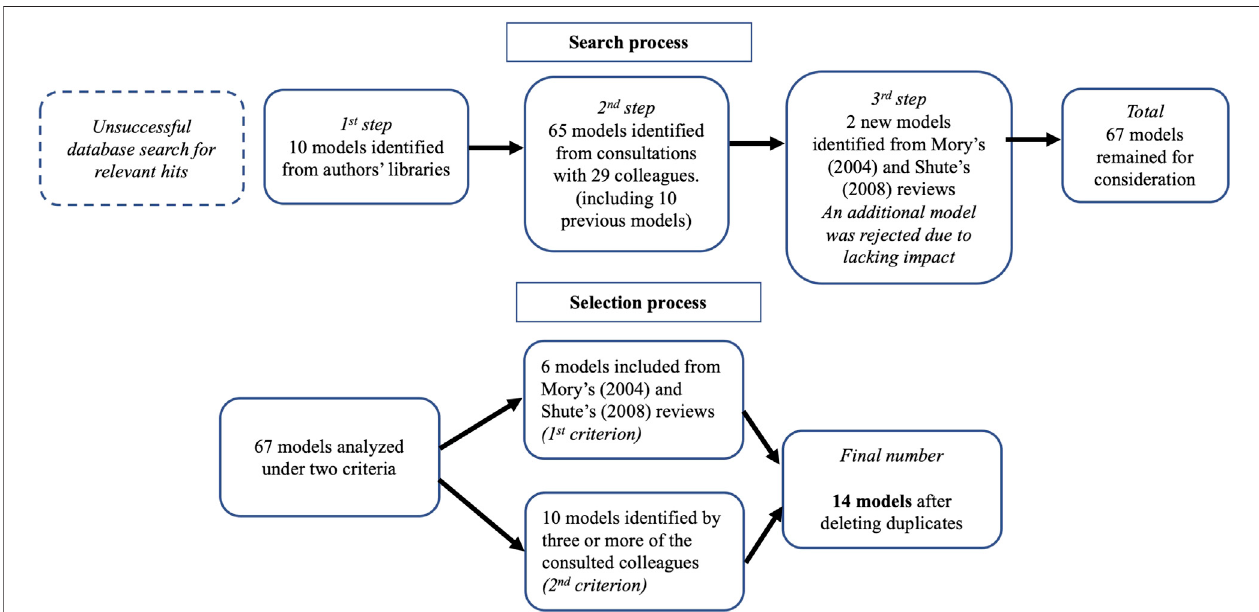
FIGURE 1 | Search and selection criteria